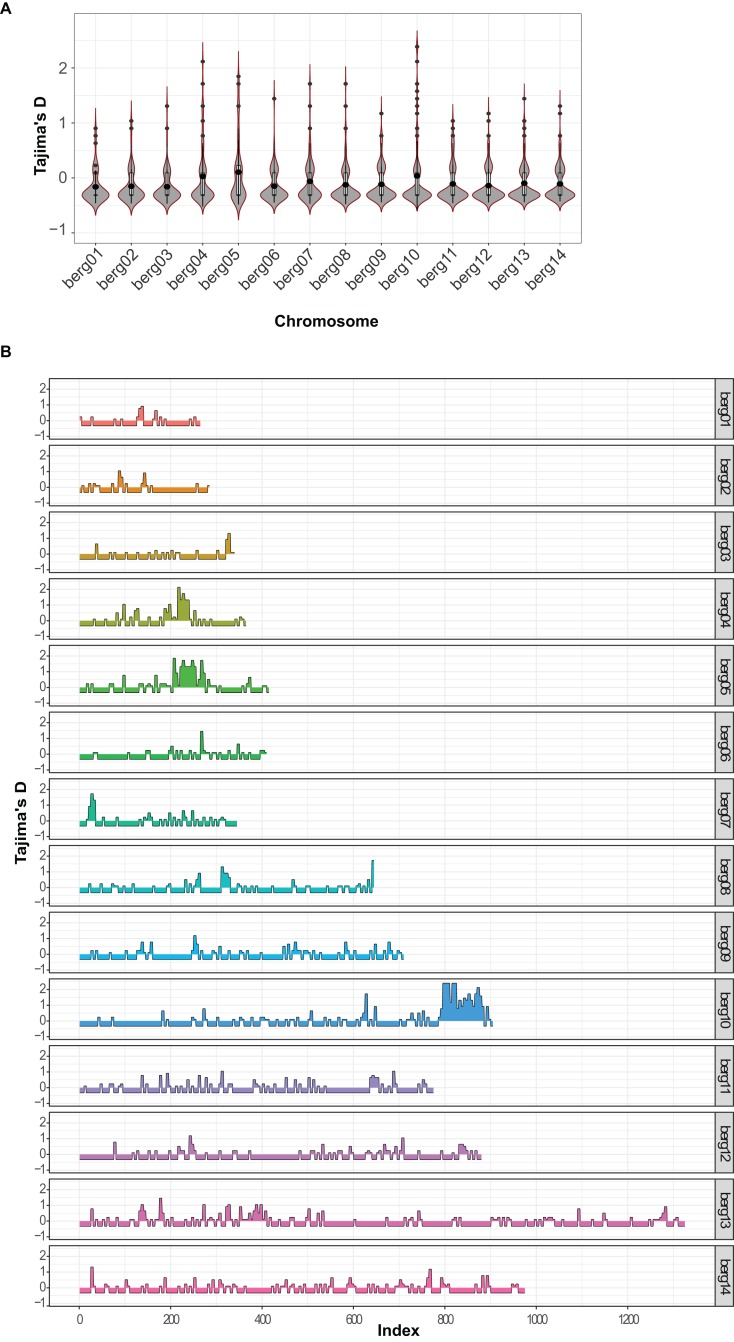
Genome-wide distribution of Tajima’s D scores in P. berghei.Tajima’s D score was calculated for sliding, non-overlapping genomic windows of five variants along all 14 chromosomes using the PopGenome tool. Scores were calculated for a total of 1,730 windows from six strains compared with the reference strain PbANKA v3. The distributions of scores in each chromosome are shown as violin plots in part (A). The scores in each window are plotted separately for each chromosome in part (B).